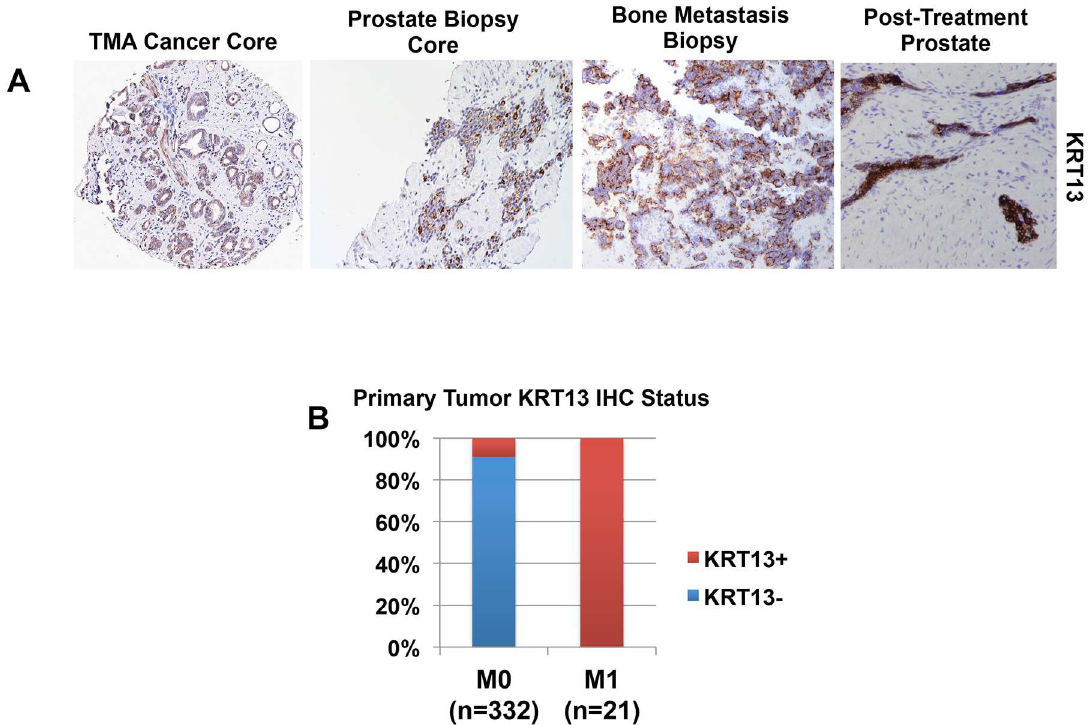
Fig 3. KRT13 expression in prostate cancer. (A) KRT13 expressionis detected (from right to left) in a cancer core from the WLA TMA, a diagnostic PNBX core from a patient with diffuse bone metastases, a biopsy of a bone metastatic site, and residualprostate glands in a prostate specimen from a patient treated with radiation and ADT. (B) Bar graph representing the relative abundanceof KRT13 + tumor foci identifiedin localized(stage M0) and metastatic (stage M1) cases. KRT13 + foci are identifiedin approximately 9% of prostate cancer cores from M0 cases in the WLA TMA. In contrast, all diagnosticPNBX from patients with diffuse bone metastases display KRT13 + tumor foci.